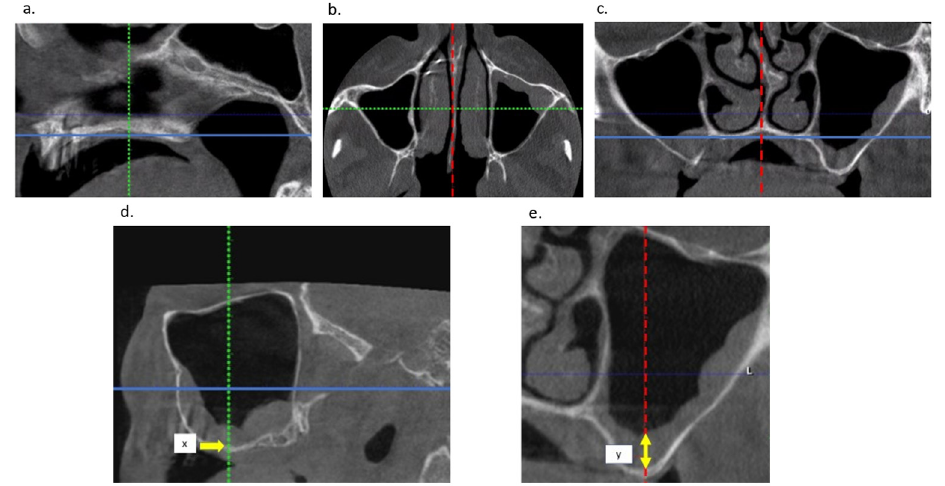
Figure 3. CBCT positioning for calibrated measurements of Schneiderian membrane thickness (Janner et al. [27]): ( a ) Sagittal view: nasal base is positioned parallel with the horizontal plane; ( b ) Axial view: the green line is the cutting slice (x) where we measured membrane thickness at the deepest basal point of the sinus (y), with the nasal septum perpendicular positioned on the horizontal plane; ( c ) Coronal view: nasal septum perpendicular on nasal base; ( d ) Demonstrating measurement position x in the sagittal plane; ( e ) Demonstrating measurement y in the coronal plane.